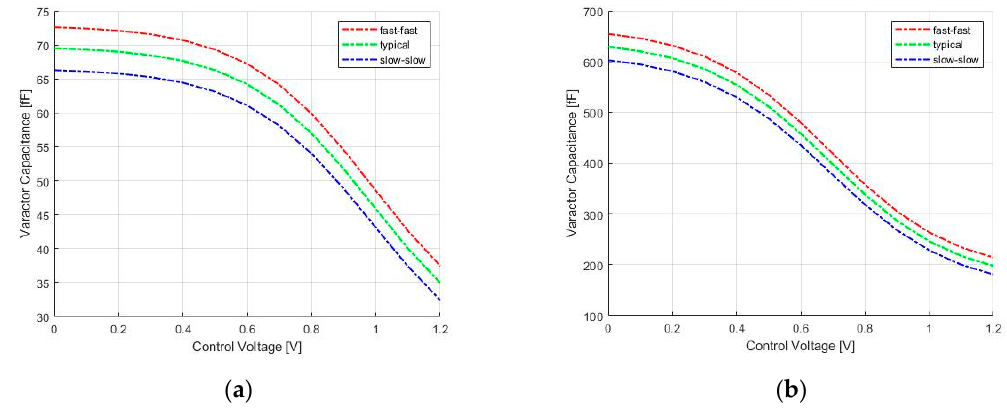
Figure 3. Varactor capacitance vs. control voltage for RO-VCO ( a ) and LC-VCO ( b ), different corner cases. RO, Ring Oscillator; VCO, Voltage Controlled Oscillator. cases. RO, Ring Oscillator; VCO, Voltage Controlled